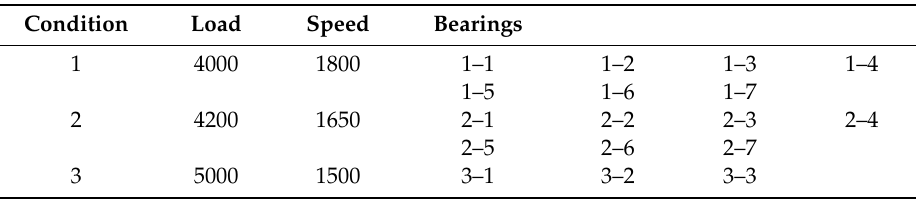
Table 9. FEMTO Dataset